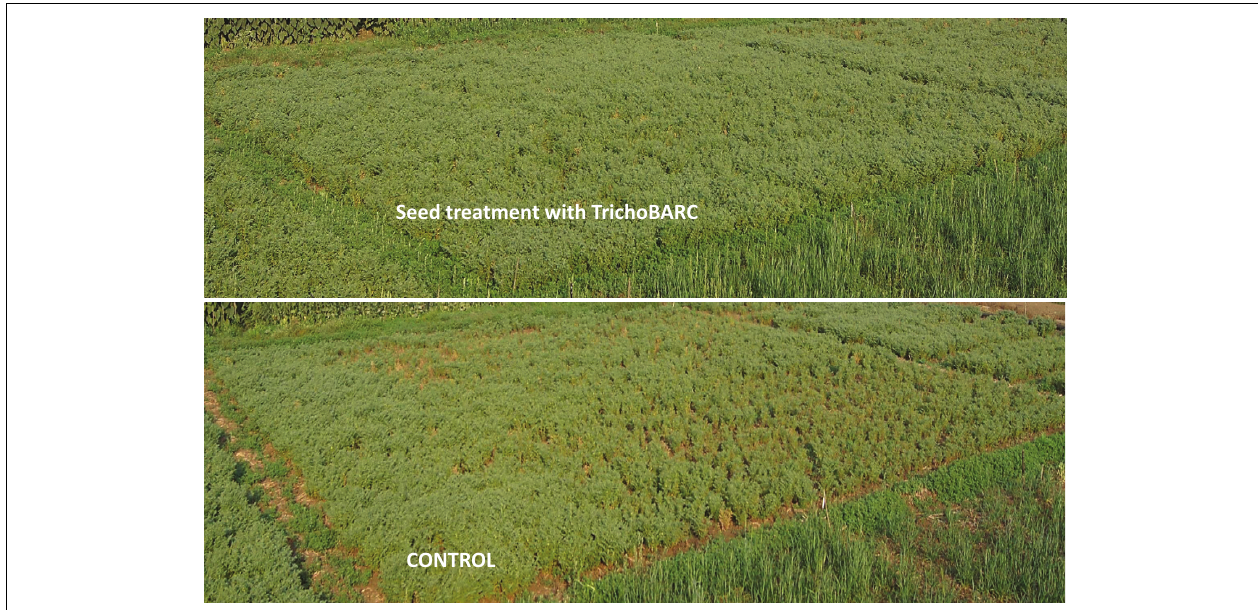
FIGURE 12 | Demonstration trial on control of collar rot of chickpea in experimental field at Raipur (2015–2016).